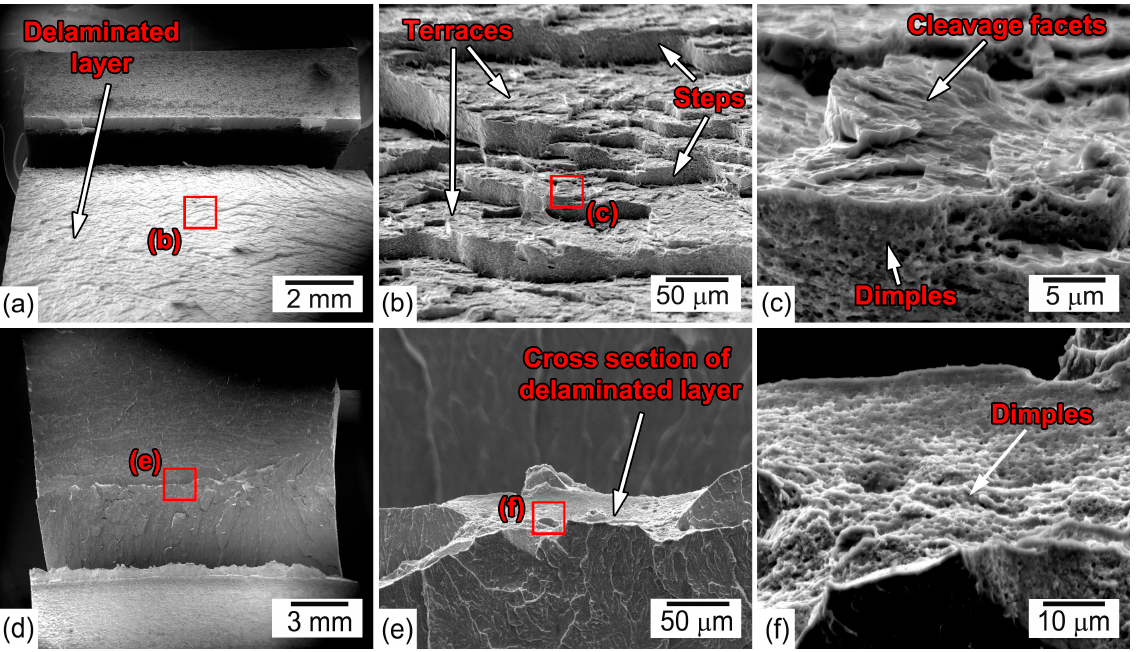
Figure 9. SEM images of fracture surface of the steel after the impact test of the ND–Charpy V-Notch specimen at room temperature. ( a – c ) tempforming at 600 ° C, ε = 0.89, ( d – f ) tempforming at 600 ° C, ε = 1.4.